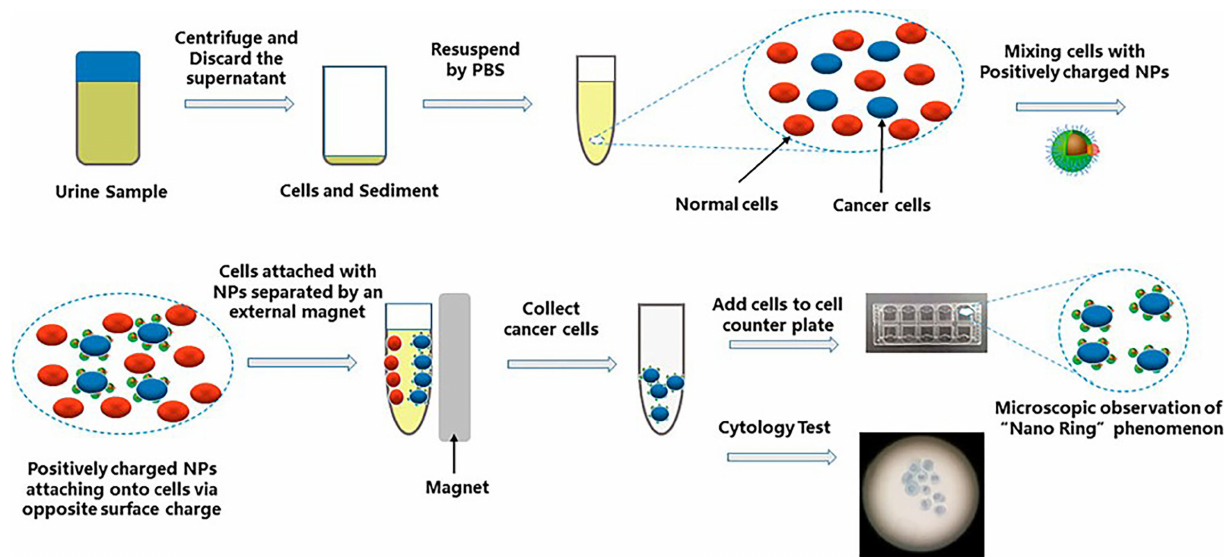
Figure 7. Schematic of nano-cytology. (Reprinted with permission Ref. [71]. Copyright © 2022 Xu, Zeng, Li, Gao, Le, Huang, Wang, Chen, Zhang and